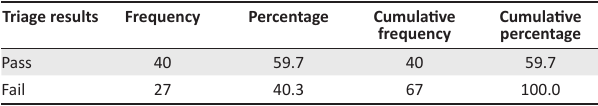
TABLE 1: Results of dysphagia triage ( n =